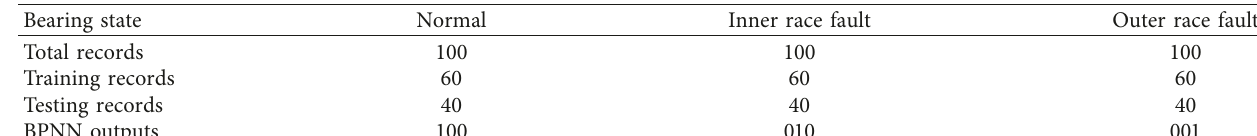
Figure 22: The Frequency domain diagram of multiresolution DMD modes of the outer race fault signal, where (a)–(h) are corresponding to signals in Figure 19, respectively. Table 7: Number of records per bearing state and BPNN outputs.